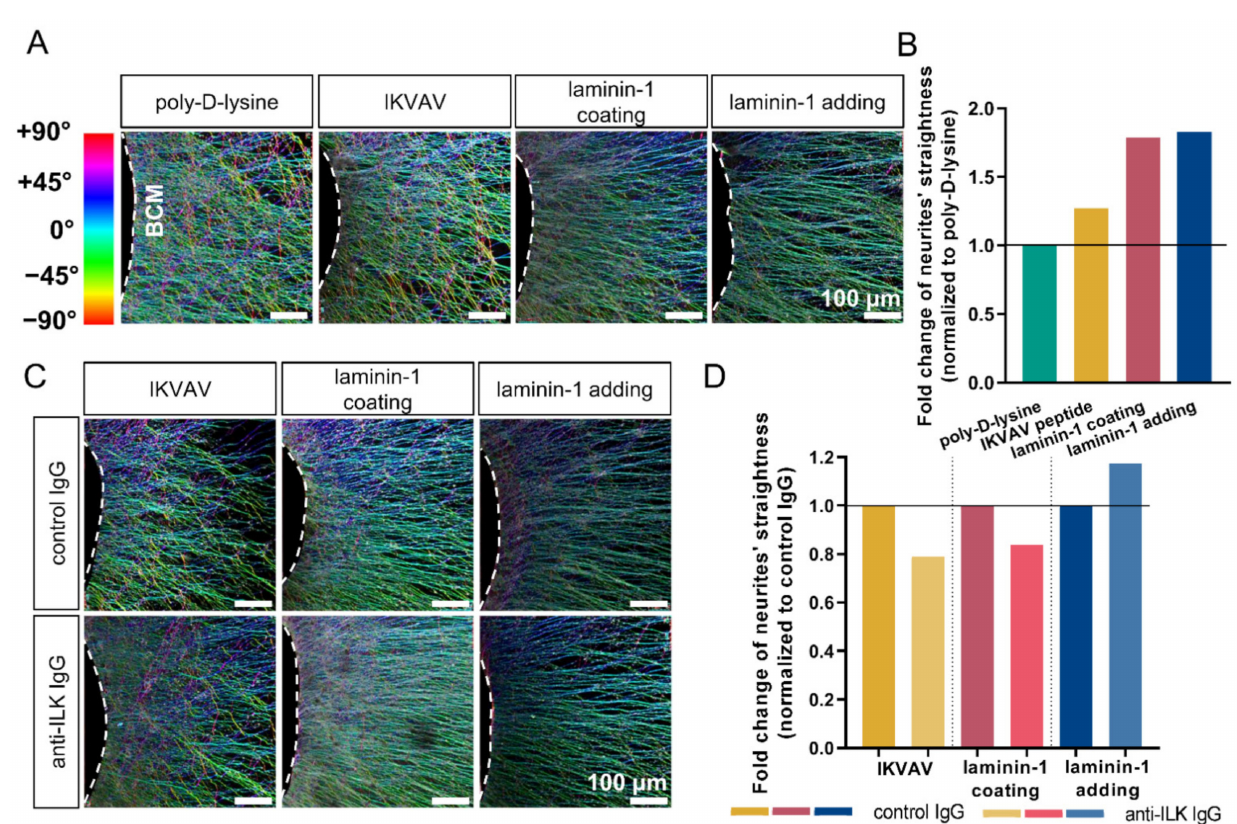
Figure 5. Interruption of ILK’s function results in changed directionality of DRG axons during extension. DRG were cultured on a laminin-1-coated surface, with IKVAV peptide, or with laminin-1 addition to the culture medium for 48 h. Additionally, control or anti-ILK antibodies were added to the medium. Next, DRG were immunostained against NF-m to visualize DRG neurites and analyzed using the OrientationJ plugin of the Fiji application. ( A ) Representative images showing color maps of DRG neurites’ orientation according to the color scale representing the deviation of the direction of neurites from 0 ◦ axis. White dashed lines represent the border of BCM; ( B ) Quantitative analysis of neurites’ straightness; ( n = 9). ( C ) Representative images showing color maps of DRG upon treatment with anti-ILK antibodies; ( D ) Quantitative analysis of neurites’ straightness after treatment with anti-ILK antibodies; ( n = 9). Final quantitative data are presented as fold changes of neurites’ straightness (normalized to the control groups for each test. A value higher than 1 indicates a more directed extension of DRG neurites, while values lower than 1 indicate their more chaotic extension. These data were calculated based on AUC from histograms generated by the OrientationJ plugin. More details can be found in the Materials and Methods section and in Supplementary Table S3 and Figure